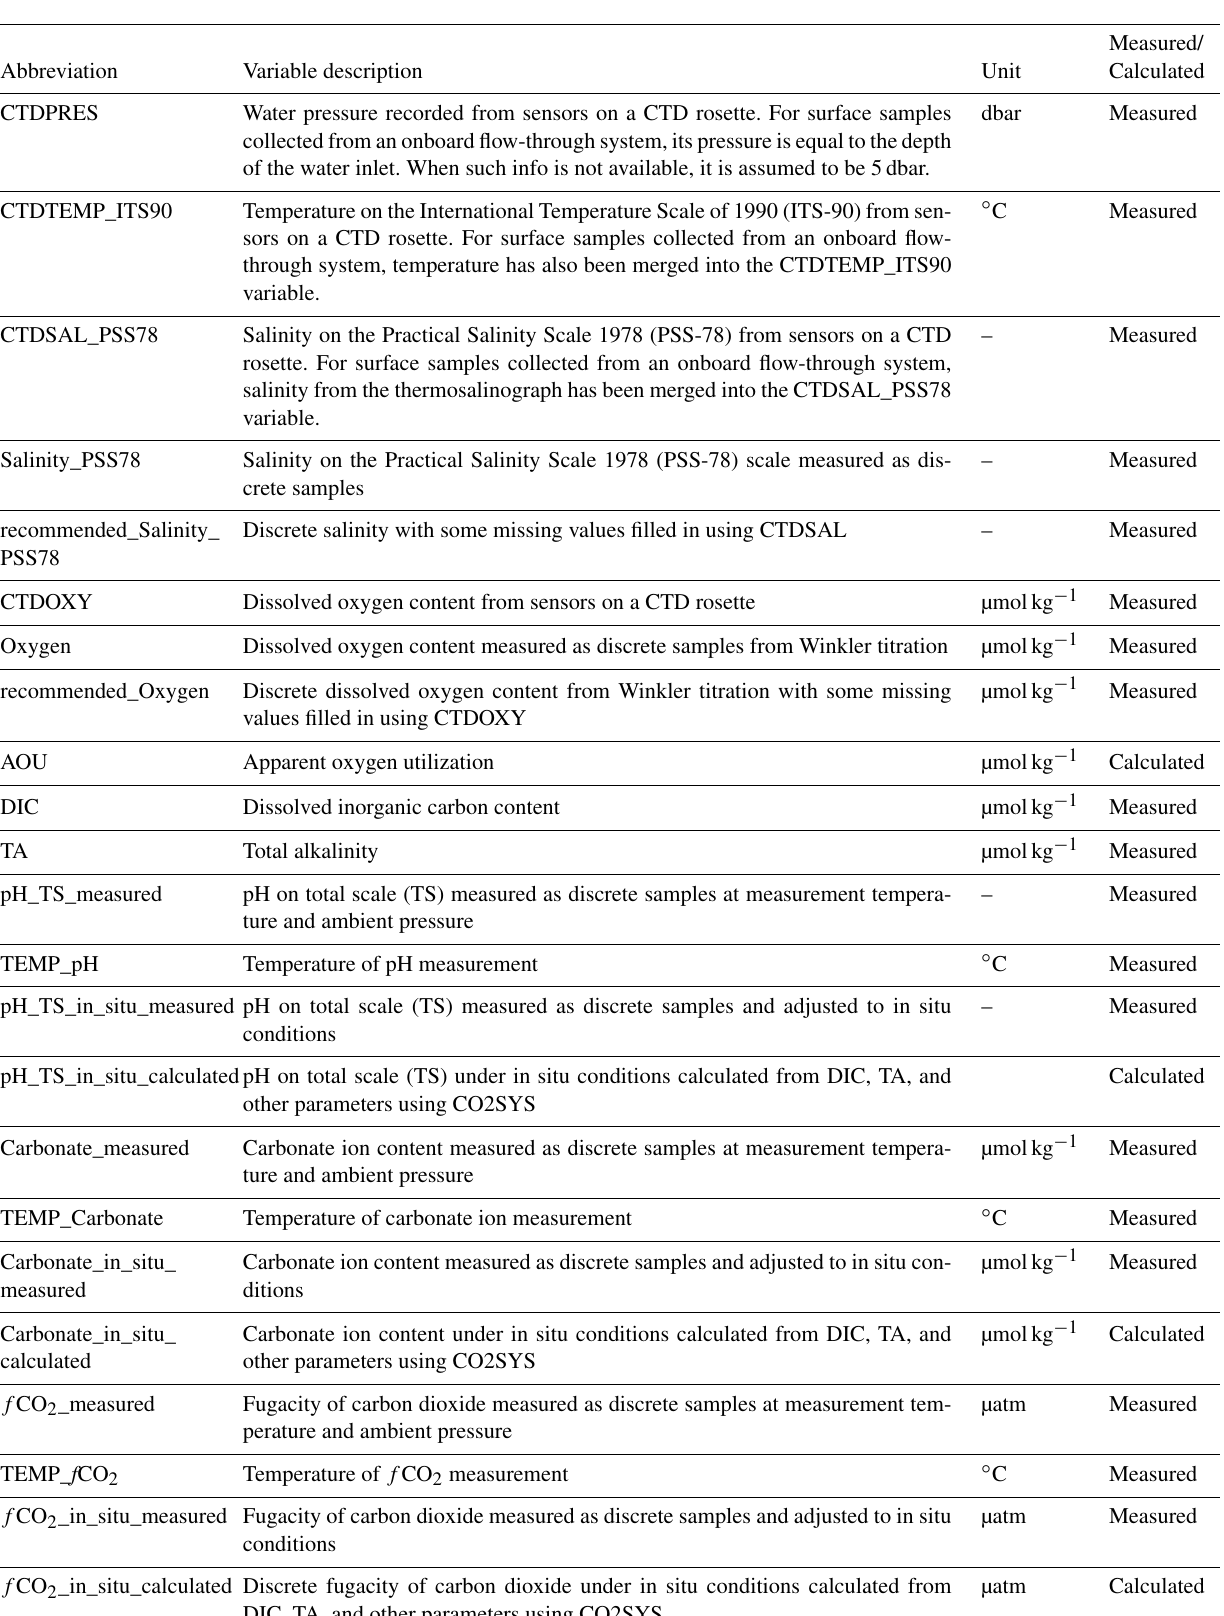
Table 1. Parameters that are included in the CODAP-NA (v2021) data